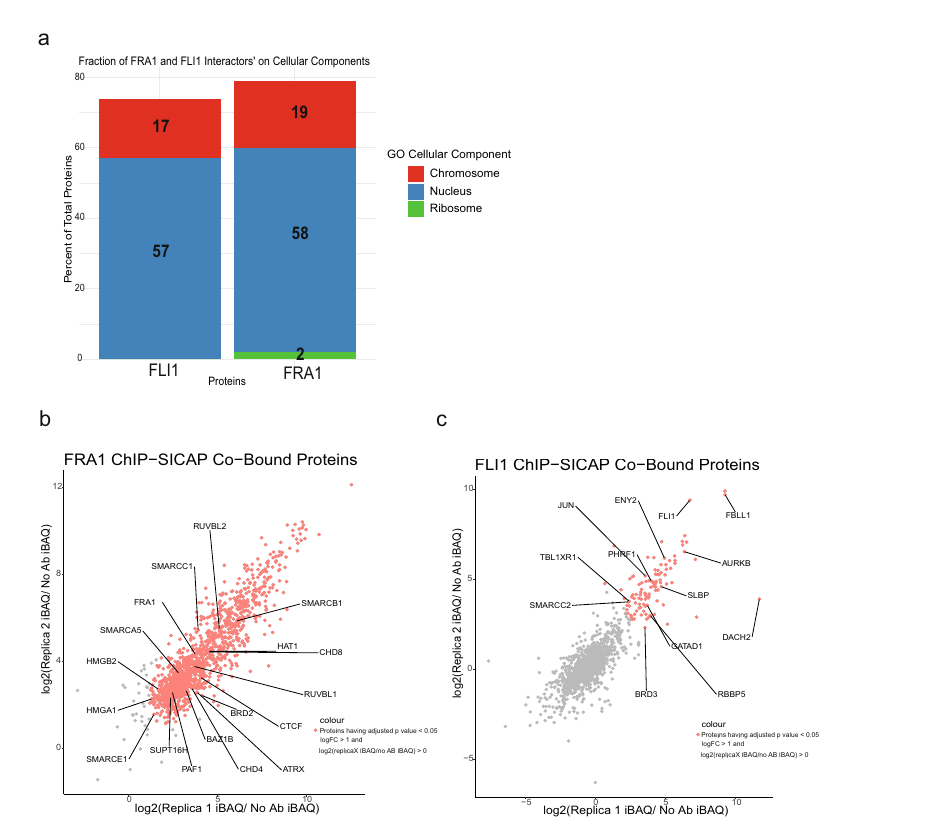
Fig. 5 Chromatin factors interacting with FRA1 and FLI1 in MIBC. a Barplots show the cellular compartments FLI1 and FRA1 chromatin-bound interactors are localized. b , c Scatter plots visualizing the correlation between ChIP-SICAP replicates for FRA1 ( b ) and FLI1 ( c ). IBAQ values are normalized to no- antibody control